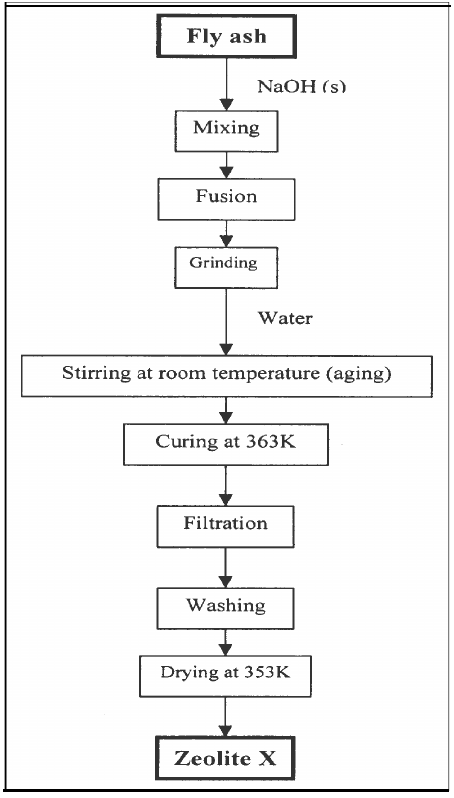
Figure 1. Process flow diagram for synthesis of zeolite from fly